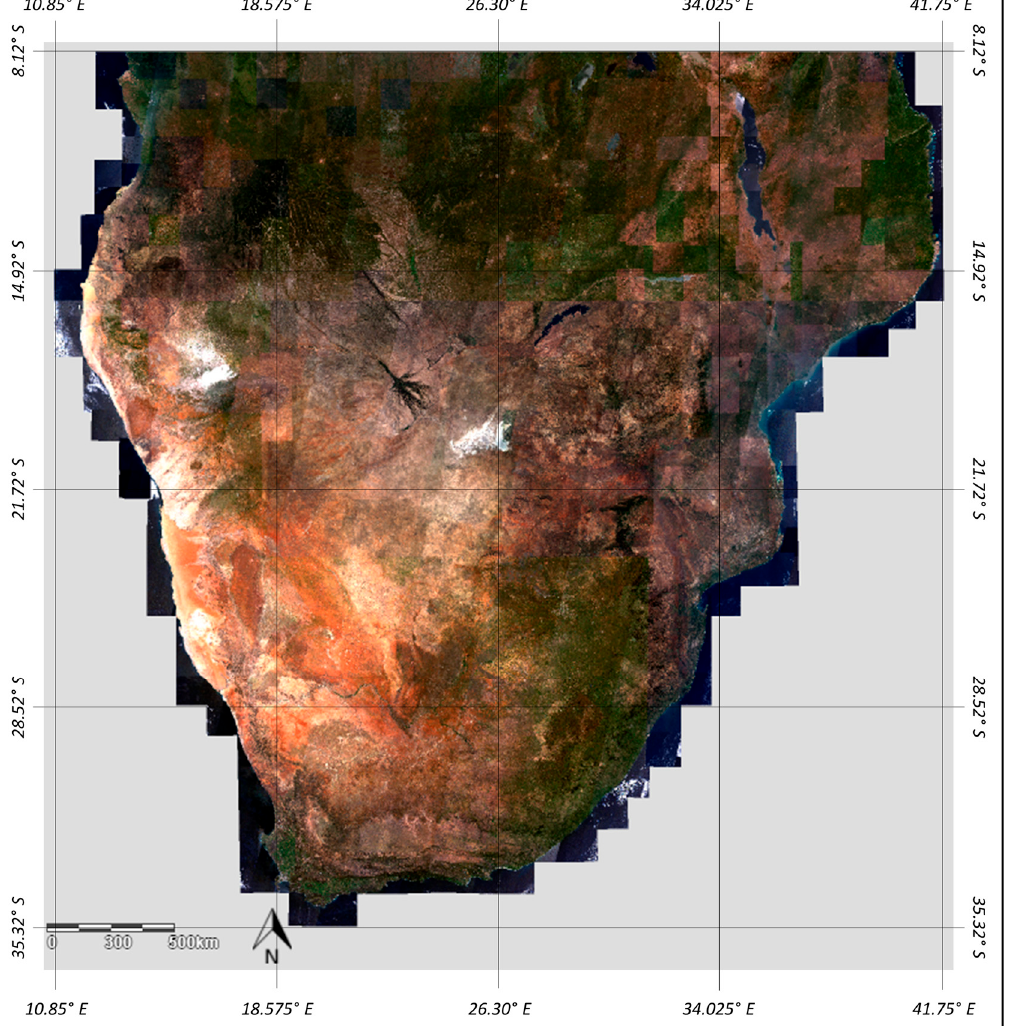
Figure 4. S2A cloud-free yearly composite—Southern Africa up to 8°S. S2A L1C granules over the AOI have been mosaicked using natural color RGB composition at 10m spatial resolution. © Contains modified Copernicus Sentinel data (2016)/Processed by ESA.